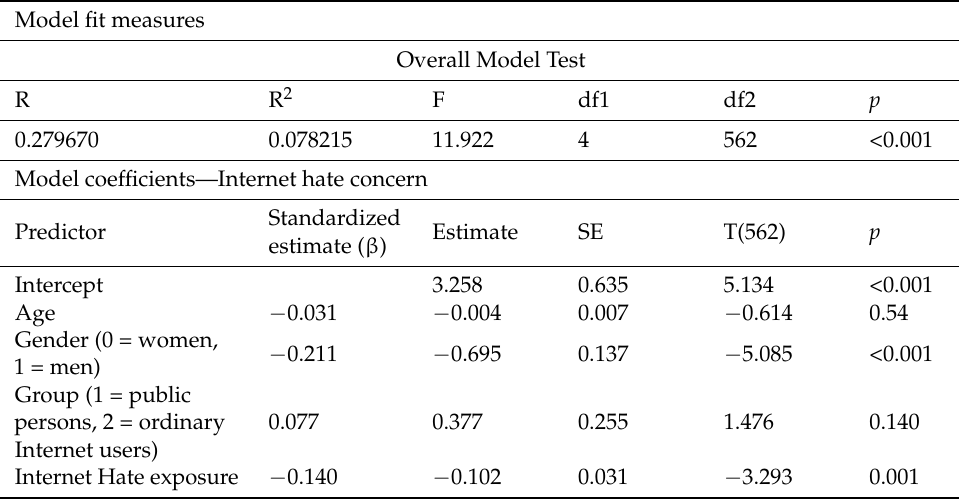
Table 6. Regression model predicting higher Internet Hate Concern ( n =